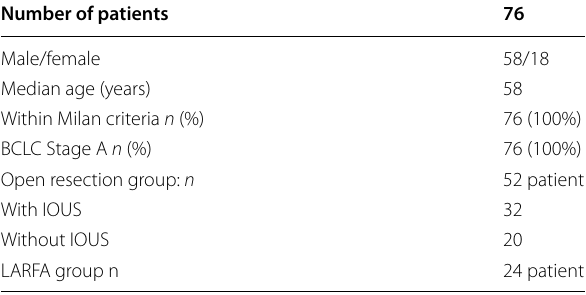
Table 1 Description of patients included in the